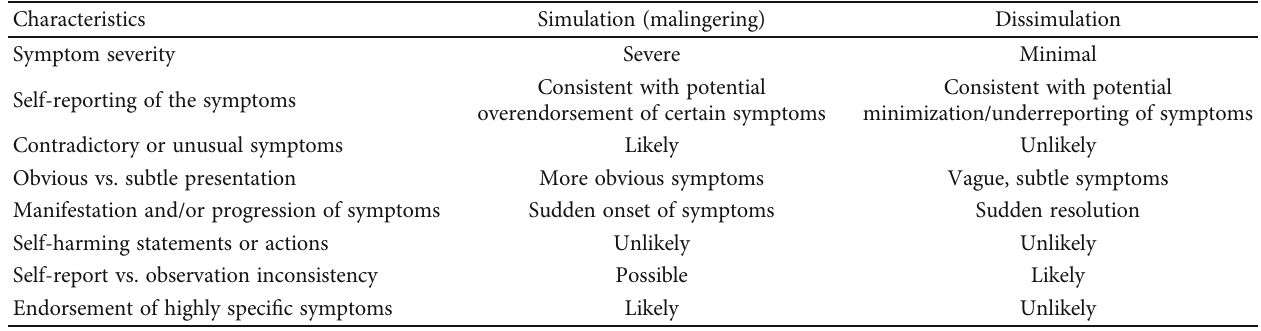
Table 3: Clinical aspects of simulation and dissimulation.